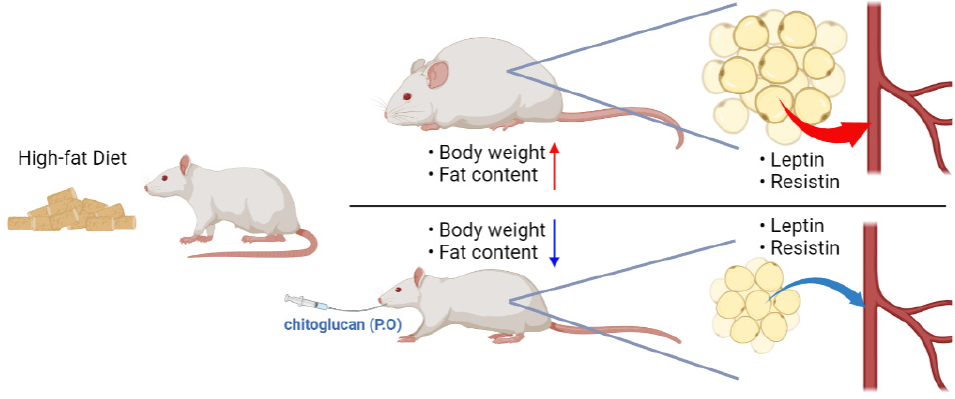
Figure 6. Summary key findings.